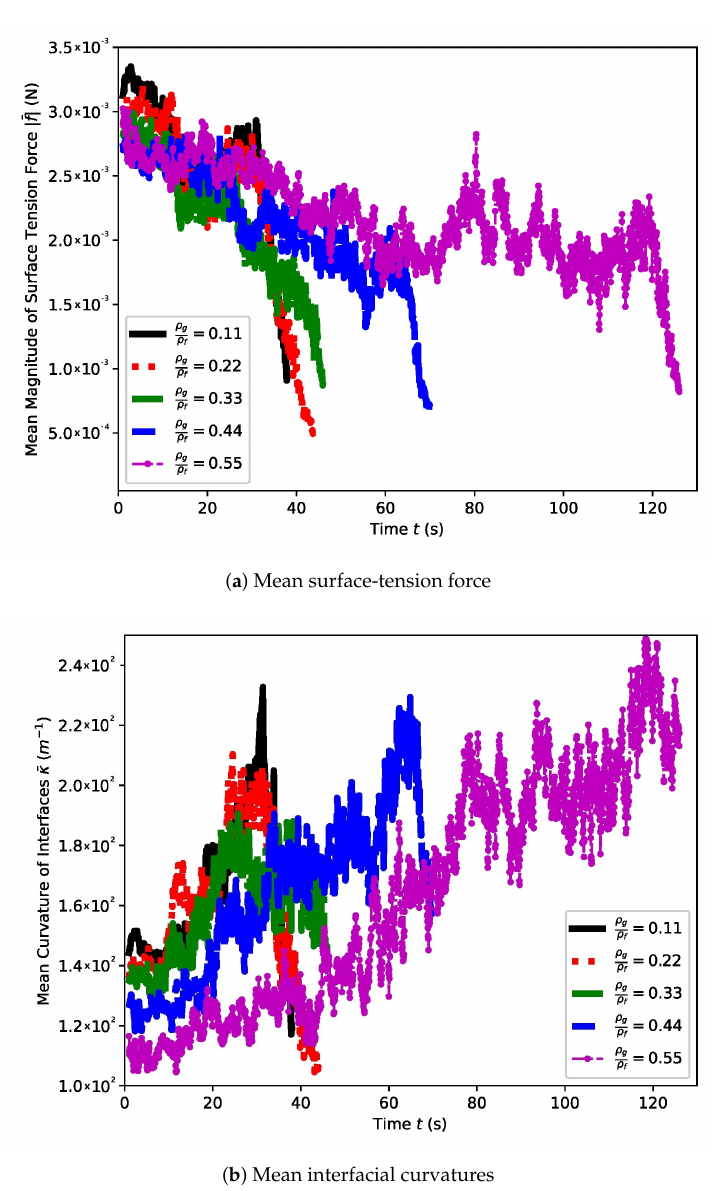
Figure 9. The mean force ¯ | f | ( a ) and mean curvature ¯ κ f ( b ) of the surface tension force for different density ratios ρ g ρ f